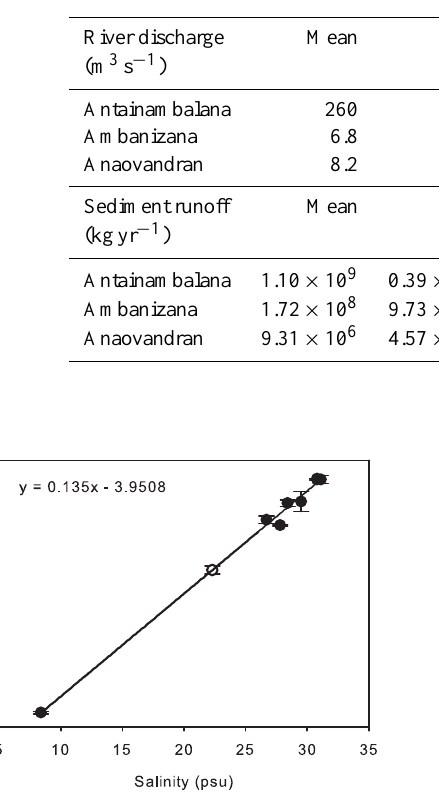
Table 4. Statistical description of modelled river discharge (upper) and sediment yield (lower) data for the three river catchments Antainam- balana, Ambanizana and Anaovandran; the closest rivers to corals MAS1, ANDRA and IFAHO, respectively. The mean, standard deviation (SD), range, maximum value (Max) and minimum value (Min) are calculated from the mean annual data spanning 15yr (1991–2005).